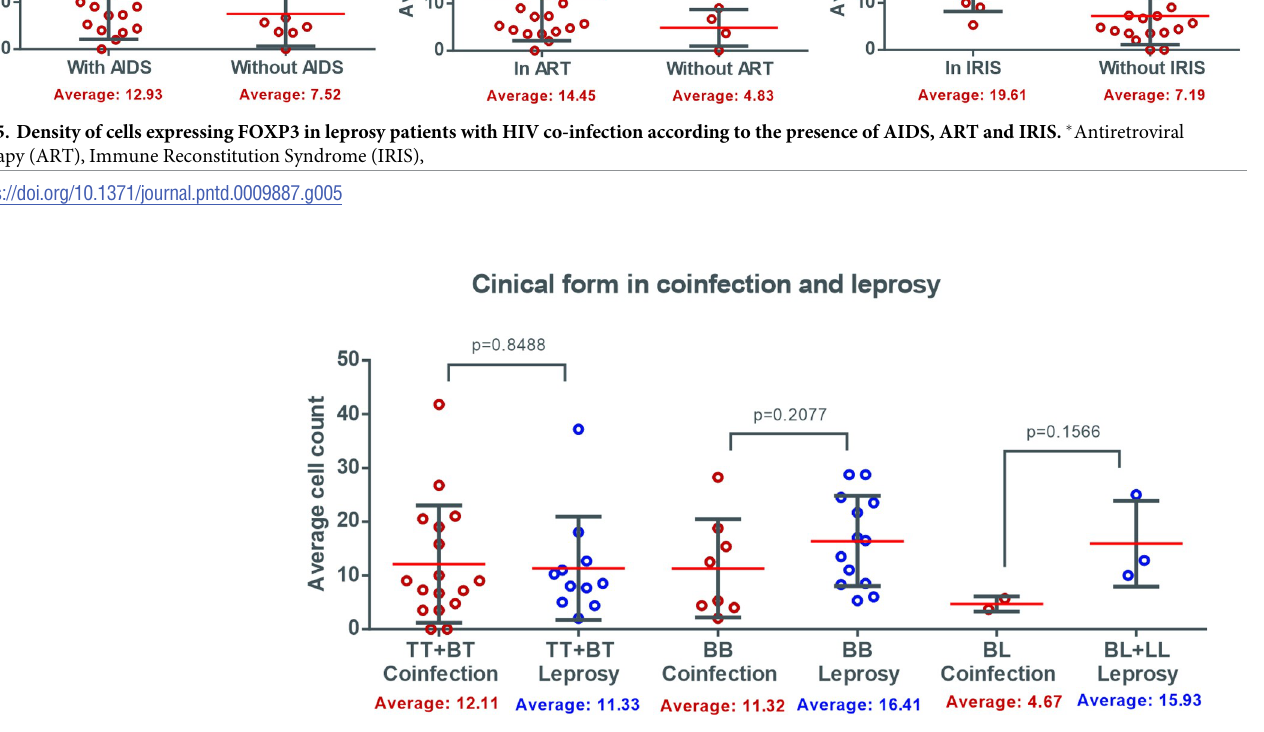
Fig 6. Density of cells expressing FOXP3 in patients with leprosy with and without HIV co-infection, according to clinical form. � (comparison between groups with isolated borderline borderline). � Clinical forms: borderline borderline (BB), borderline tuberculoid (BT), tuberculoid (TT), borderline lepromatous (BL) and lepromatous (LL).